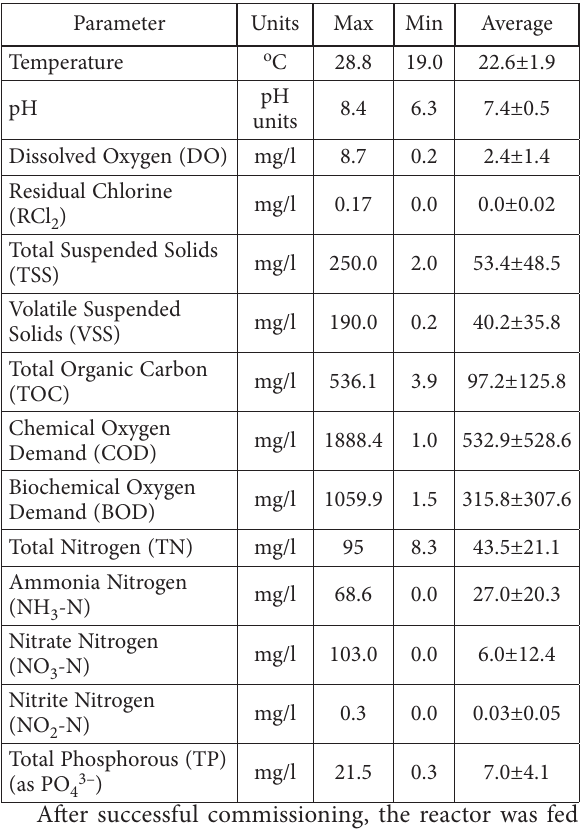
Table 1. Characteristics of the